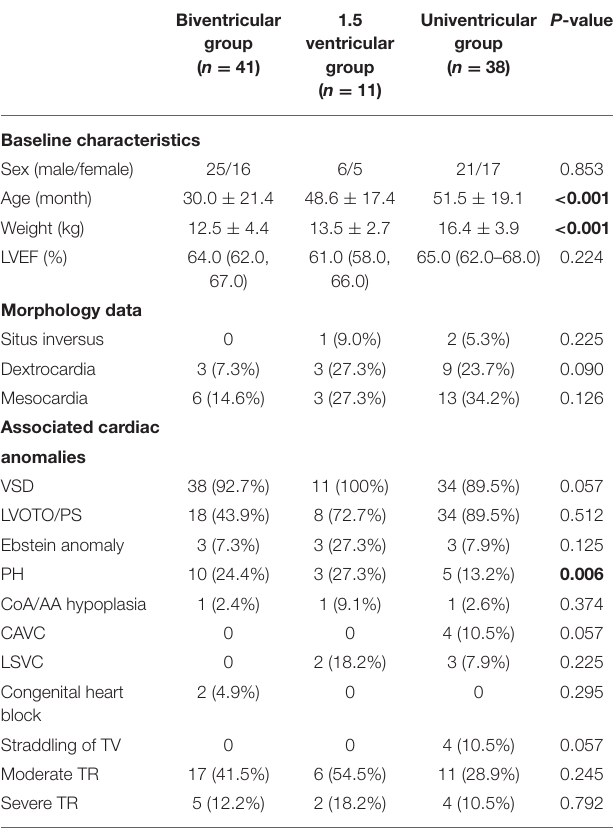
TABLE 1 | Baseline characteristics stratified by different surgical